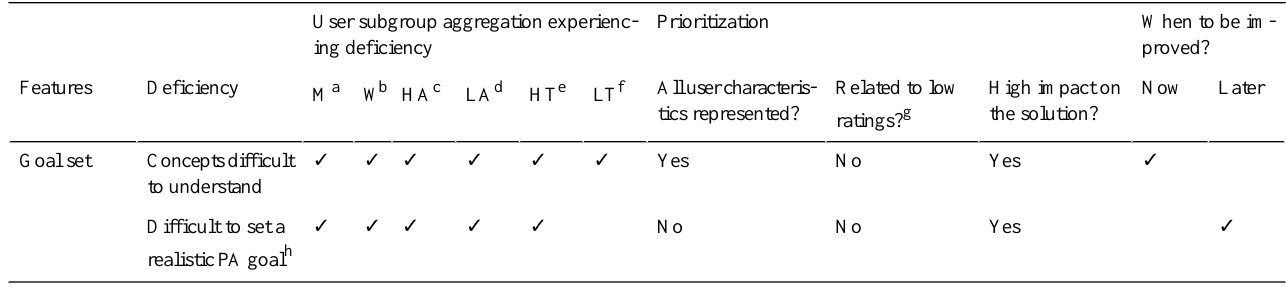
When to be im- proved?PrioritizationUser subgroup aggregation experienc-